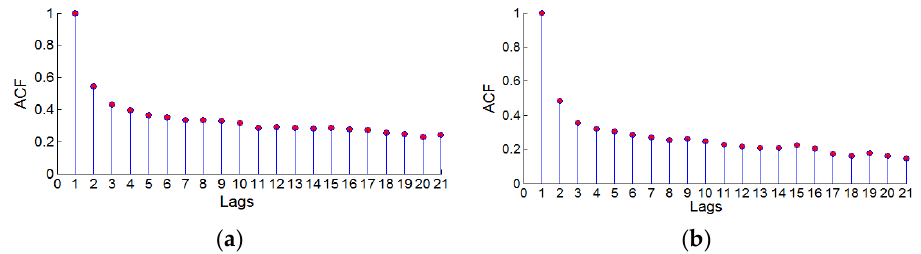
Figure 10. The autocorrelation graph of bjfs and lhaz CORS stations height residual sequence. ( a ) bjfs and ( b ) bogo.